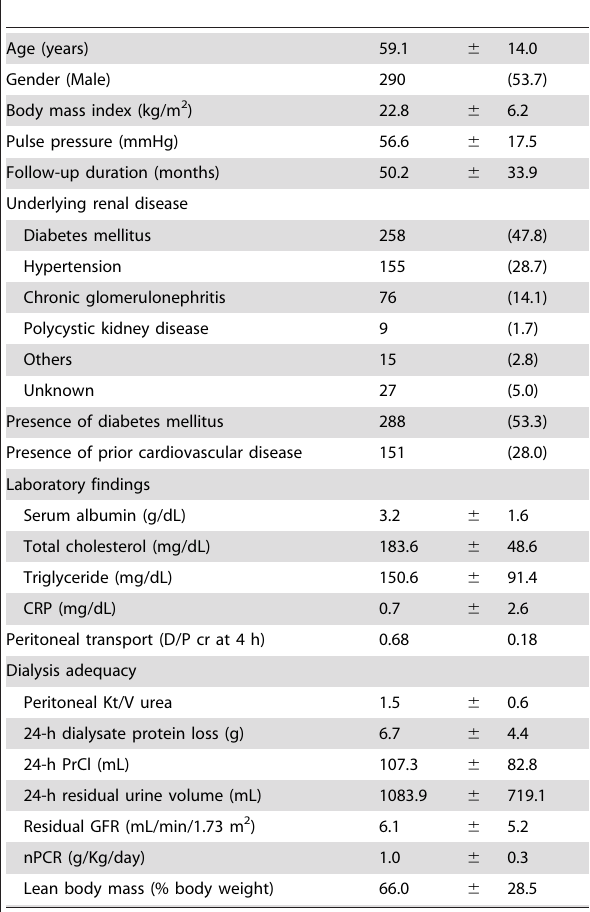
Table 1. Baseline characteristics of the study subjects (n=540).